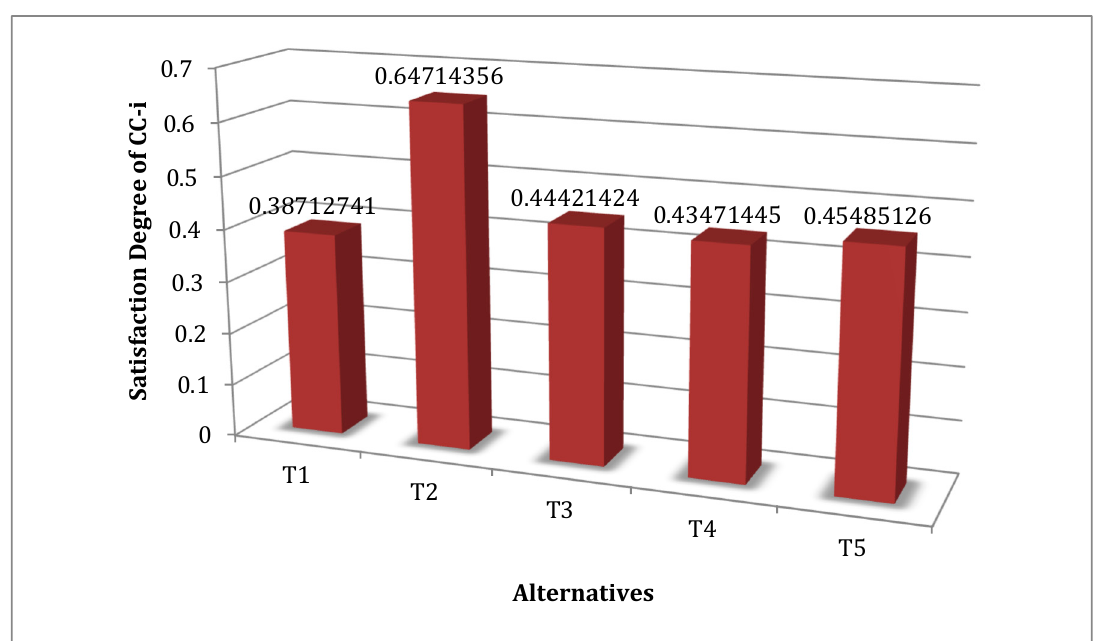
Figure 10. A graphical representation of the satisfaction degree of CC − i.